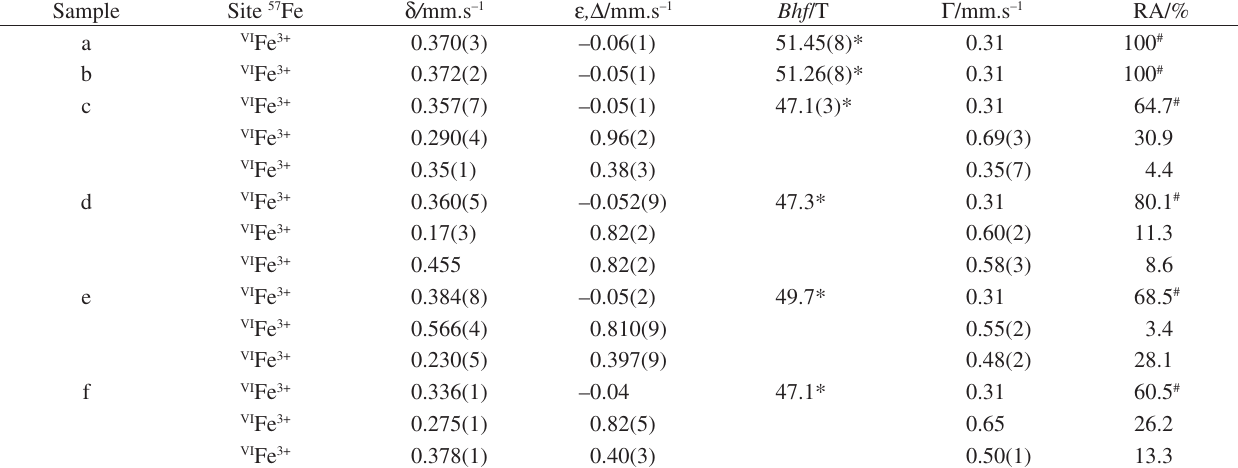
O corresponding to spectra recorded at 298 K. 2 3